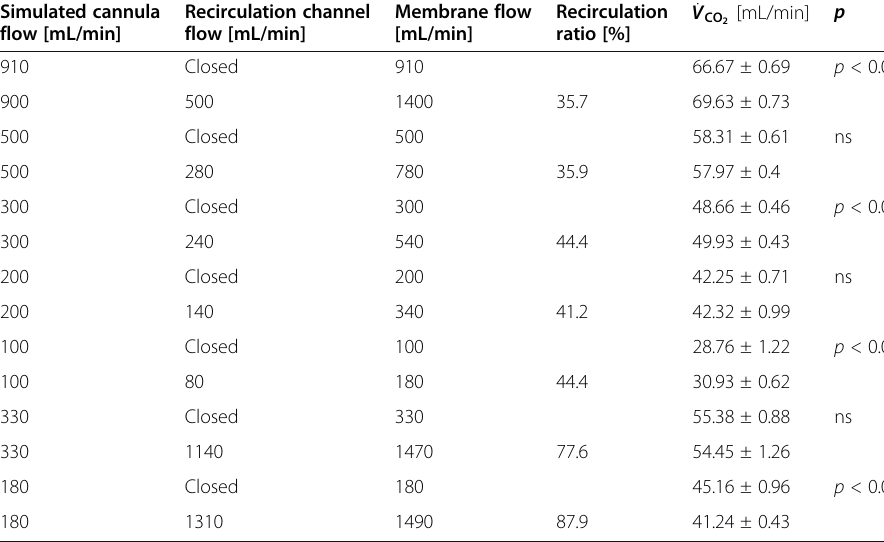
Table 2 Effect of a recirculation channel on CO 2 elimination Simulated cannula flow